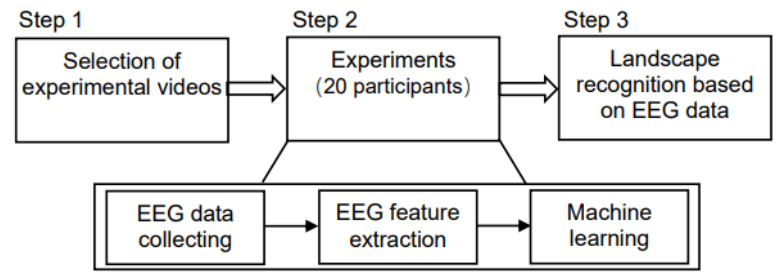
Figure 3. Flow chart of the experiment.